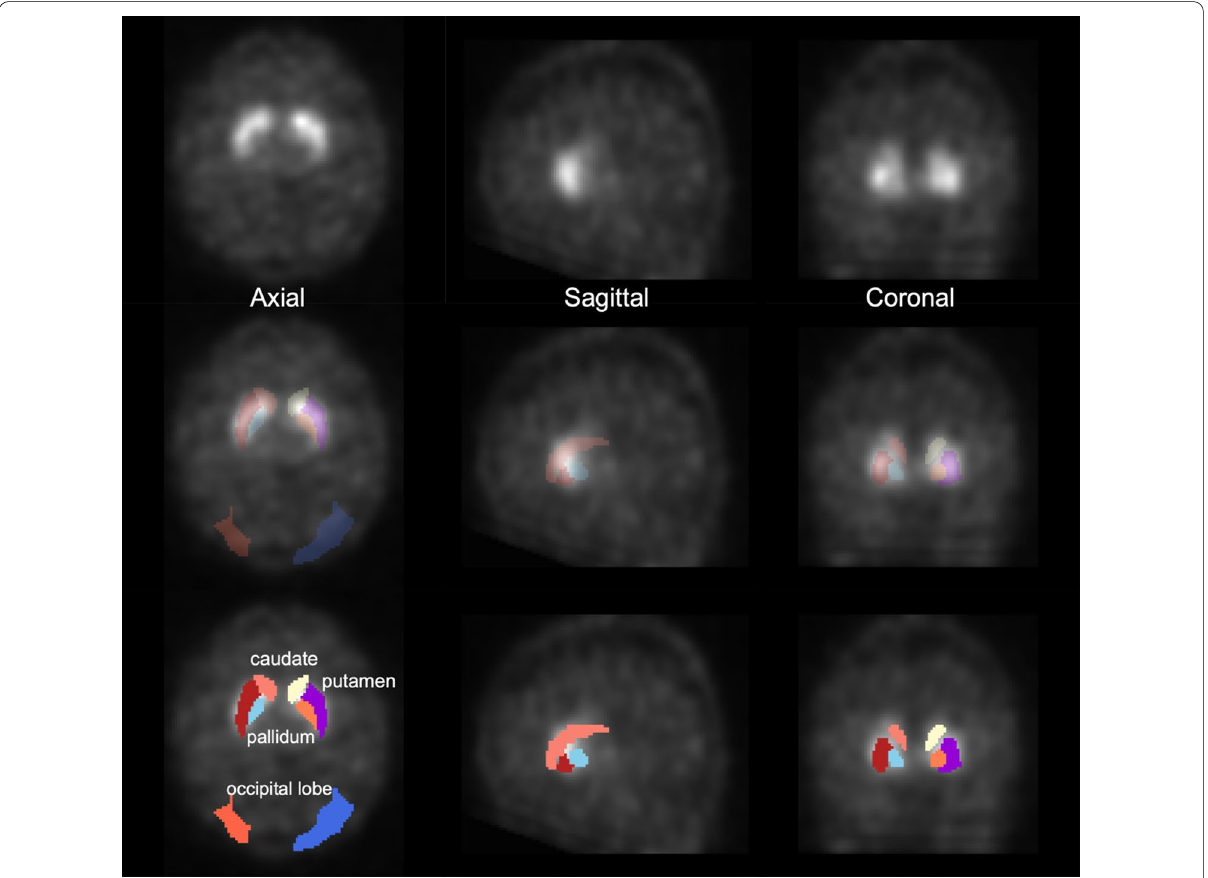
Fig. 1 An example of settings of a voxel of interests for calculating radiomics features and semi-quantitative indices. The upper row indicates after the spatial normalisation dopamine transporter single-photon emission computed tomography, and the middle and lower rows indicate fused image. The coloured area of the middle and lower rows indicates the striatum and background (occipital